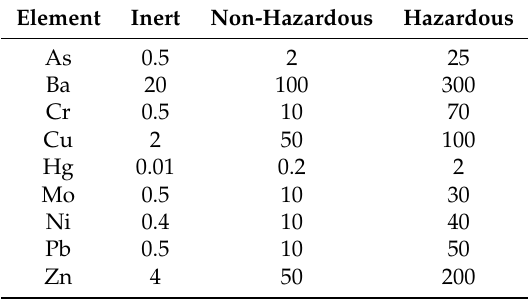
Table 1. Limit values (mg · kg − 1 ) established by the European Landfill Directive [29] to classify solid waste for its admission to